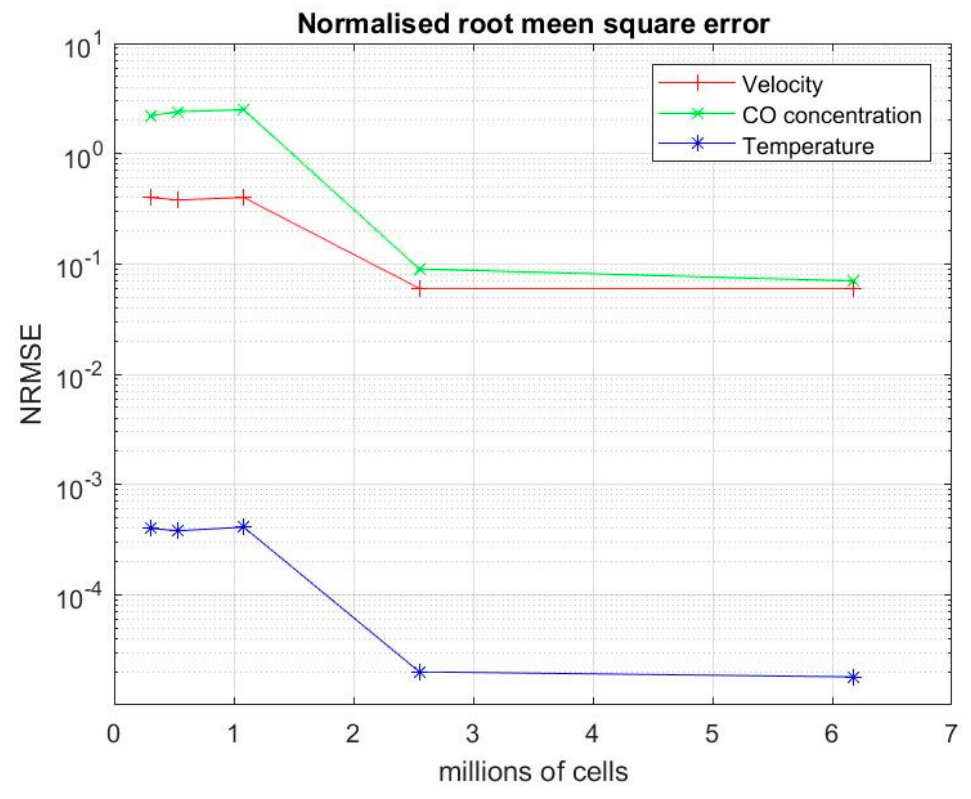
Figure A2. Convergence tests results.